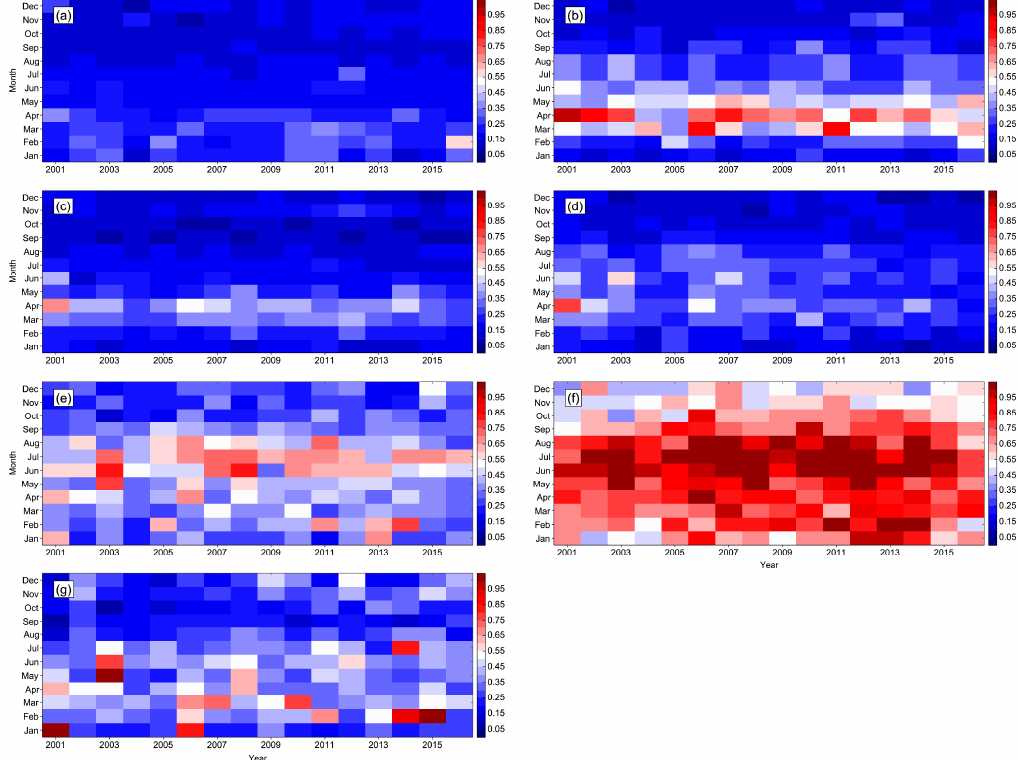
Figure 5. Regional-averaged AOD distribution in relation to month and year in ( a ) northern Xinjiang, ( b ) southern Xinjiang, ( c ) Qinghai Tibet, ( d ) Northwest China, ( e ) North China Plain, ( f ) East China, and ( g ) Northeast China, for the period 2001–2016.